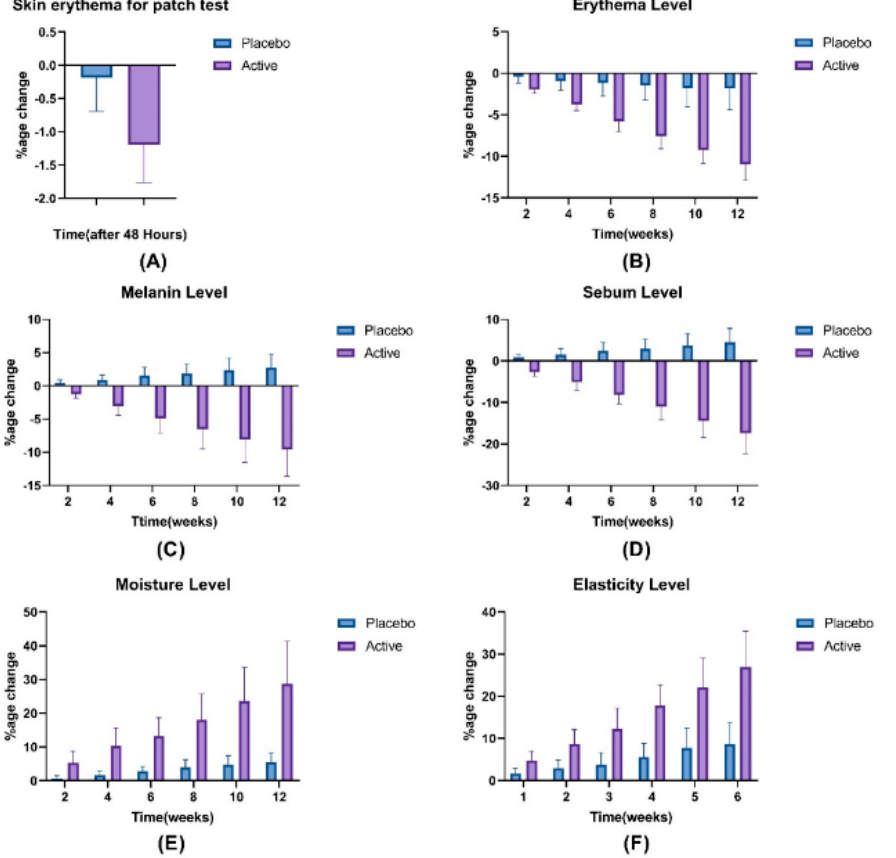
Figure 7. In vivo evaluation of placebo and active microemulgels. ( A ), skin erythema; ( B ), erythema level; ( C ), melanin level; ( D ), sebum level; ( E ), moisture level; ( F ), elasticity level.